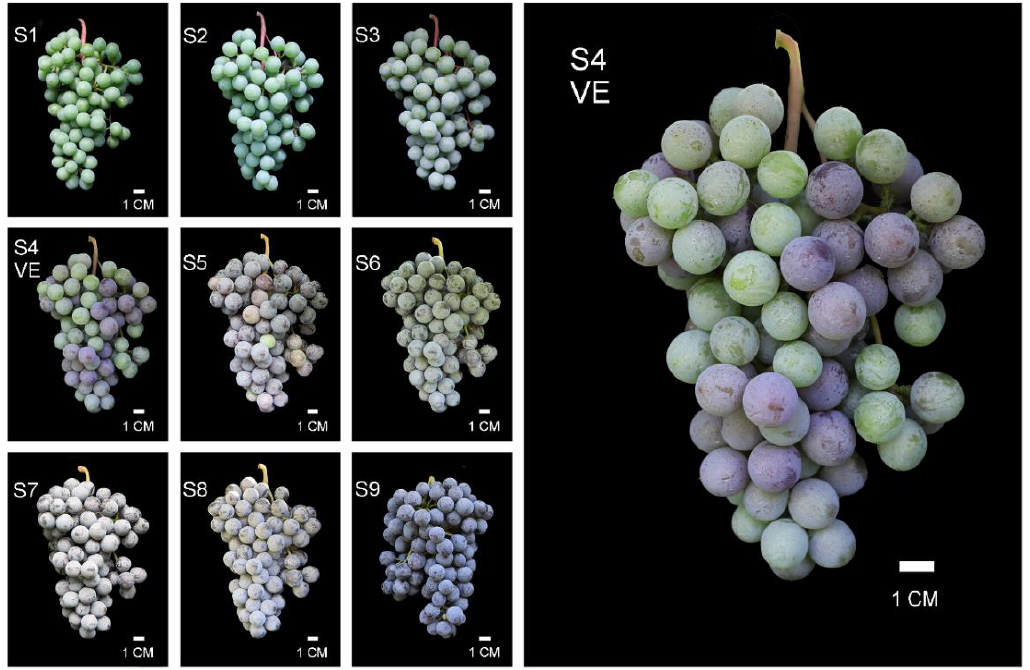
Figure A4. Photos of ‘Xinbeichun’ were taken during sampling time in 2019. S1–S9 represent the sampling date in 2019, and bar = 1 cm.